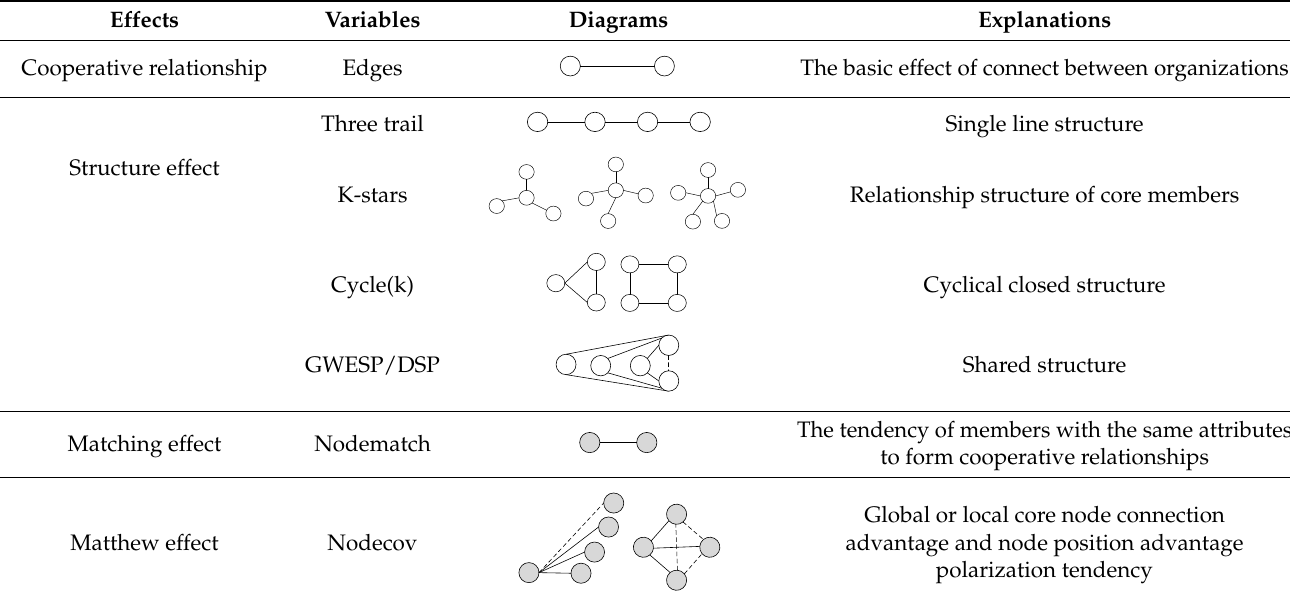
Table 2. Variables and their explanations.